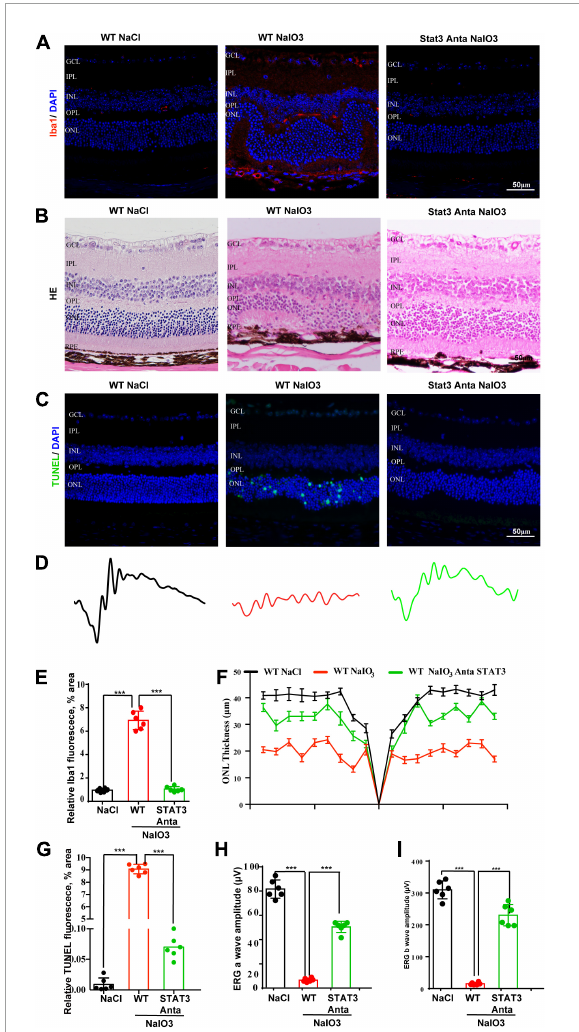
FIGURE8 A pSTAT3 inhibitor inhibits microglial activation and rescues the retinal function of wild-type mice after NaIO 3 induction. (A) Immunostaining of Iba in the retinas of saline control- and NaIO 3 -treated WT and pSTAT3-inhibited mice. (B) H&E staining of the retinas of saline control- and NaIO 3 -treated WT and pSTAT3-inhibited mice. (C) TUNEL immunofluorescence staining of retinas of saline control- and NaIO 3 -treated WT and pSTAT3-inhibited mice. (D) ERG analysis of retinal function in saline control- and NaIO 3 -treated WT and pSTAT3-inhibited mice. (E) Quantification of Iba1 in saline control- and NaIO 3 -treated WT and pSTAT3-inhibited mice. (F) Quantification of ONL thickness in the retinas of saline control- and NaIO 3 -treated WT and pSTAT3-inhibited mice. (G) Quantification of TUNEL in retinas of saline control- and NaIO 3 -treated WT and pSTAT3-inhibited mice. (H,I) Bar plot of the amplitudes of a and b waves in saline control- and NaIO 3 -treated WT and pSTAT3-inhibited mice. *** p <